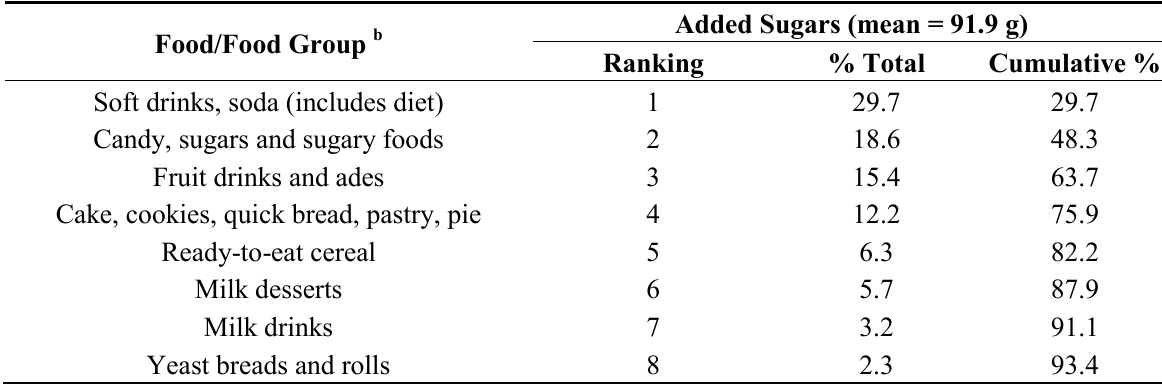
Table 5. Food/Food group sources of added sugars among US children aged 2–18 years (from NHANES 2003–2006) a .